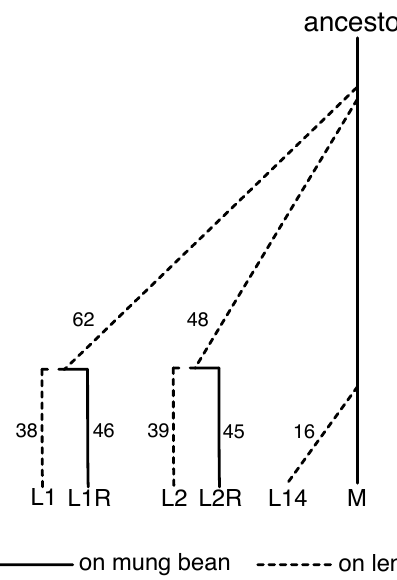
Figure 1. Illustration of the history of the C. maculatus lines discussed in this manuscript (i.e., L1, L2, L1R, L2R and L14) along with the South Indian mung line (denoted M). The number of generations that elapsed between the origin of each line and our final sample for population genomic analyses is shown. Details on additional samples including those used for the backcross mapping families and gene expression experiments can be found in Table